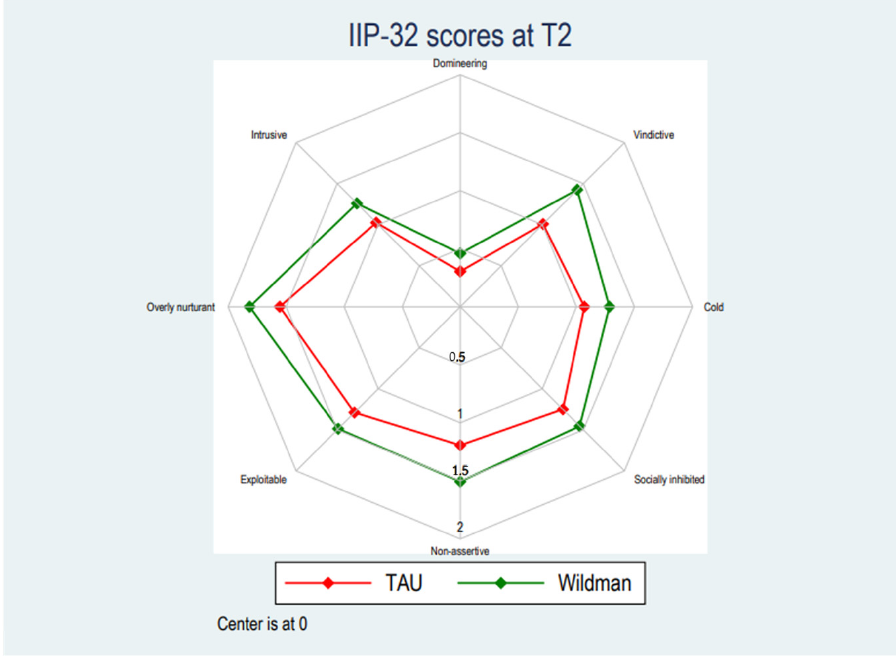
Figure 2. Post-intervention score pattern for TAU and the Wildman Programme-group.